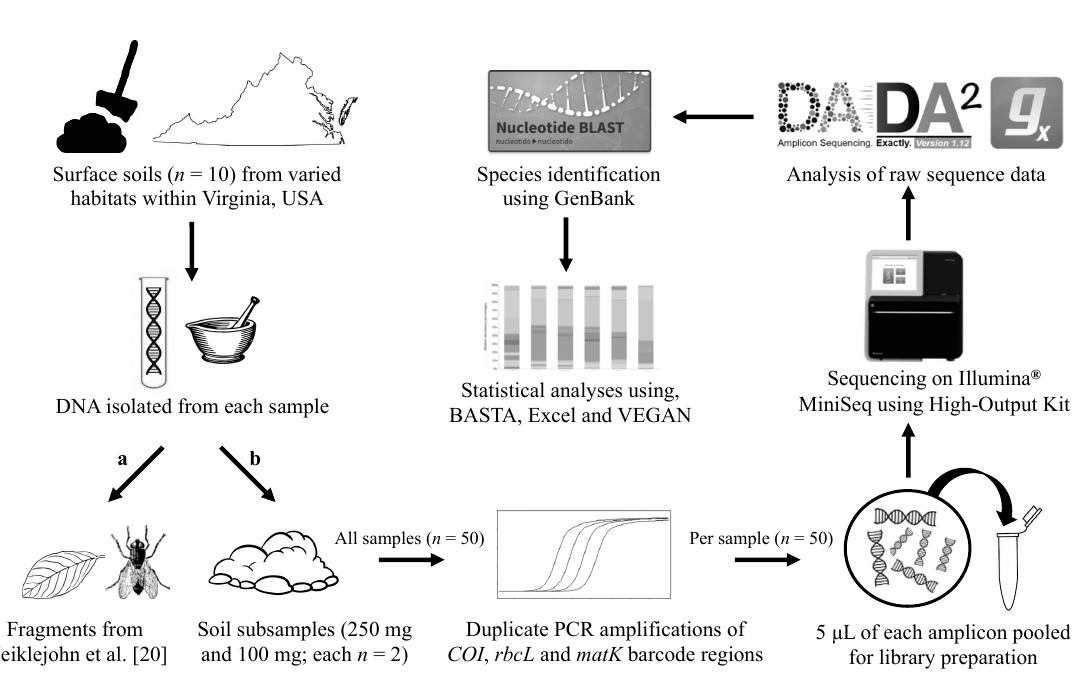
Figure 1. Schematic illustrating the major steps in the generation and analysis of DNA metabarcode data in this study: sample collection, DNA extraction, barcode region amplification, library preparation and sequencing, and sequence and statistical analyses.